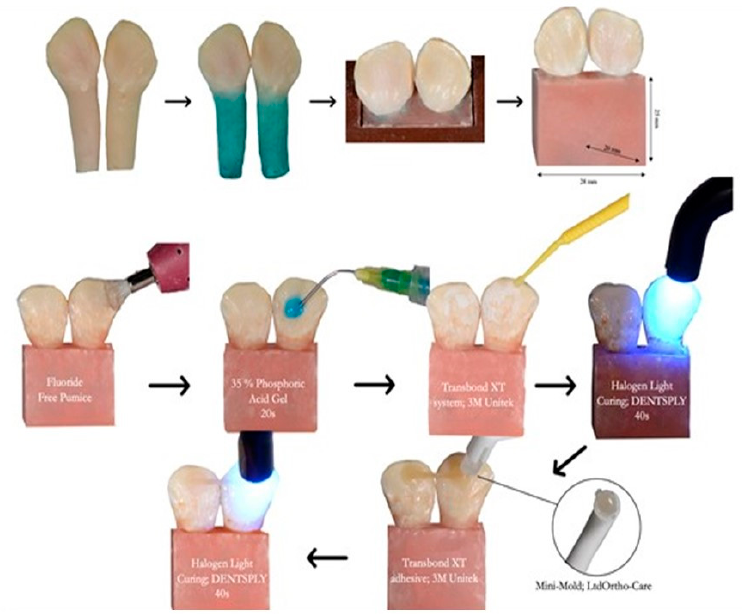
Figure 1. Molding of teeth, preparation, and placement of retainer on bovine teeth.